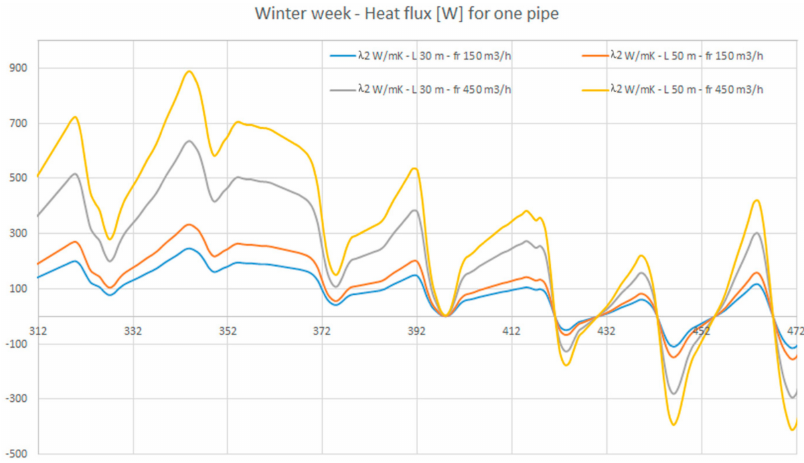
Figure 10. Heat flux [W] for one pipe during the winter week (14–20